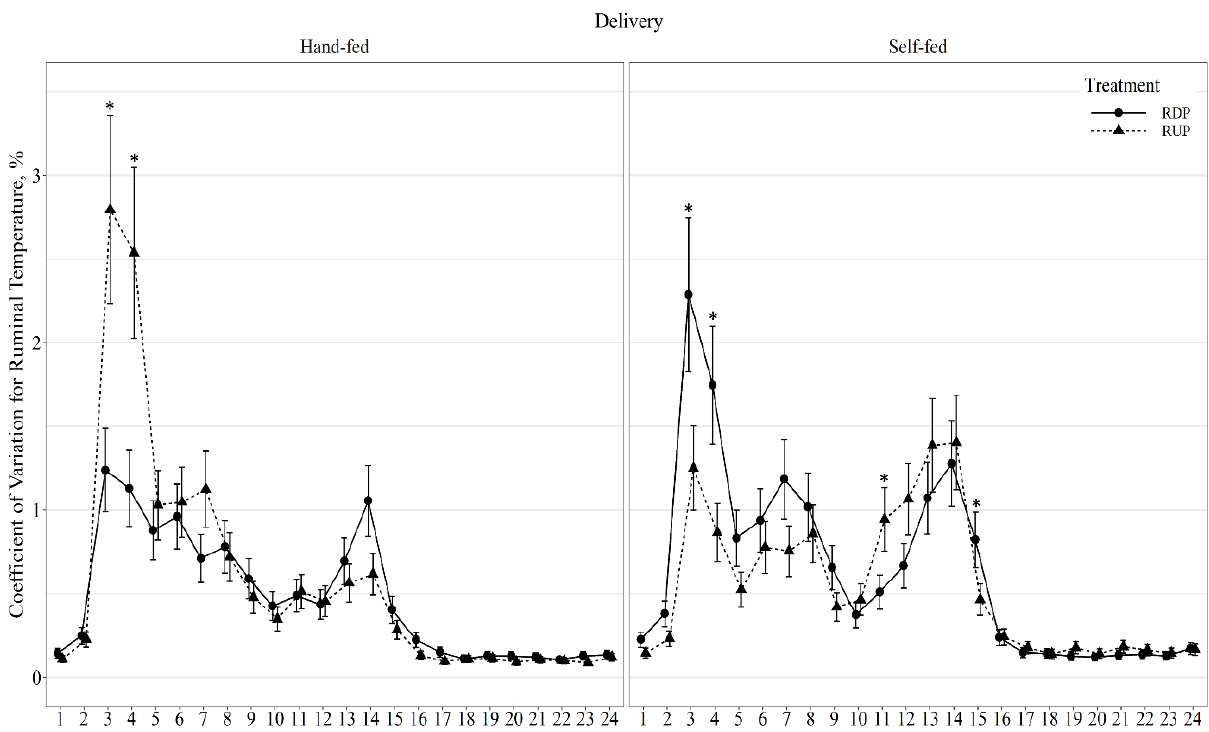
Figure 4. Diurnal ruminal temperature coefficient of variation (CV, %) patterns of beef cows fed hand-fed or self-fed rumen degradable (RDP) or rumen undegradable (RUP) protein supplements with low-quality forage at 08:00. Ruminal temperature CV was influenced by delivery method × protein type × hour post-feeding interaction ( p < 0.01), and differences ( p ≤ 0.05) within hour post-feeding are denoted by *.